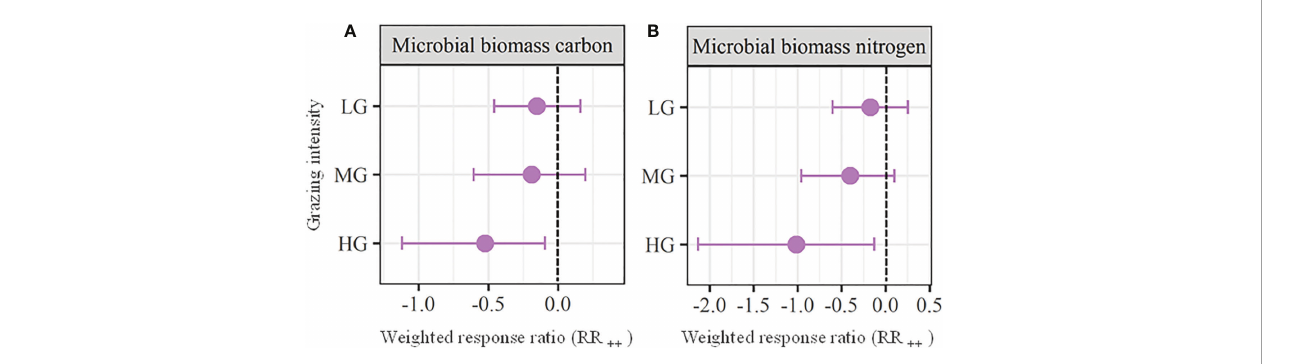
FIGURE 5 Weighted response ratios (RR ++ ) and their 95% con fi dence intervals (CI) for soil microbiomes including microbial biomass carbon (A) and microbial biomass nitrogen (B) in the lightly (LD), moderately (MD), and heavily (HG) grazing alpine grasslands. The overall effect sizes are unitless grand means from weighted meta-analyses. The dots with error bars indicate the mean effect size with the 95% CI. The observed effect sizes were considered statistically signi fi cant ifthe 95% CI did not include